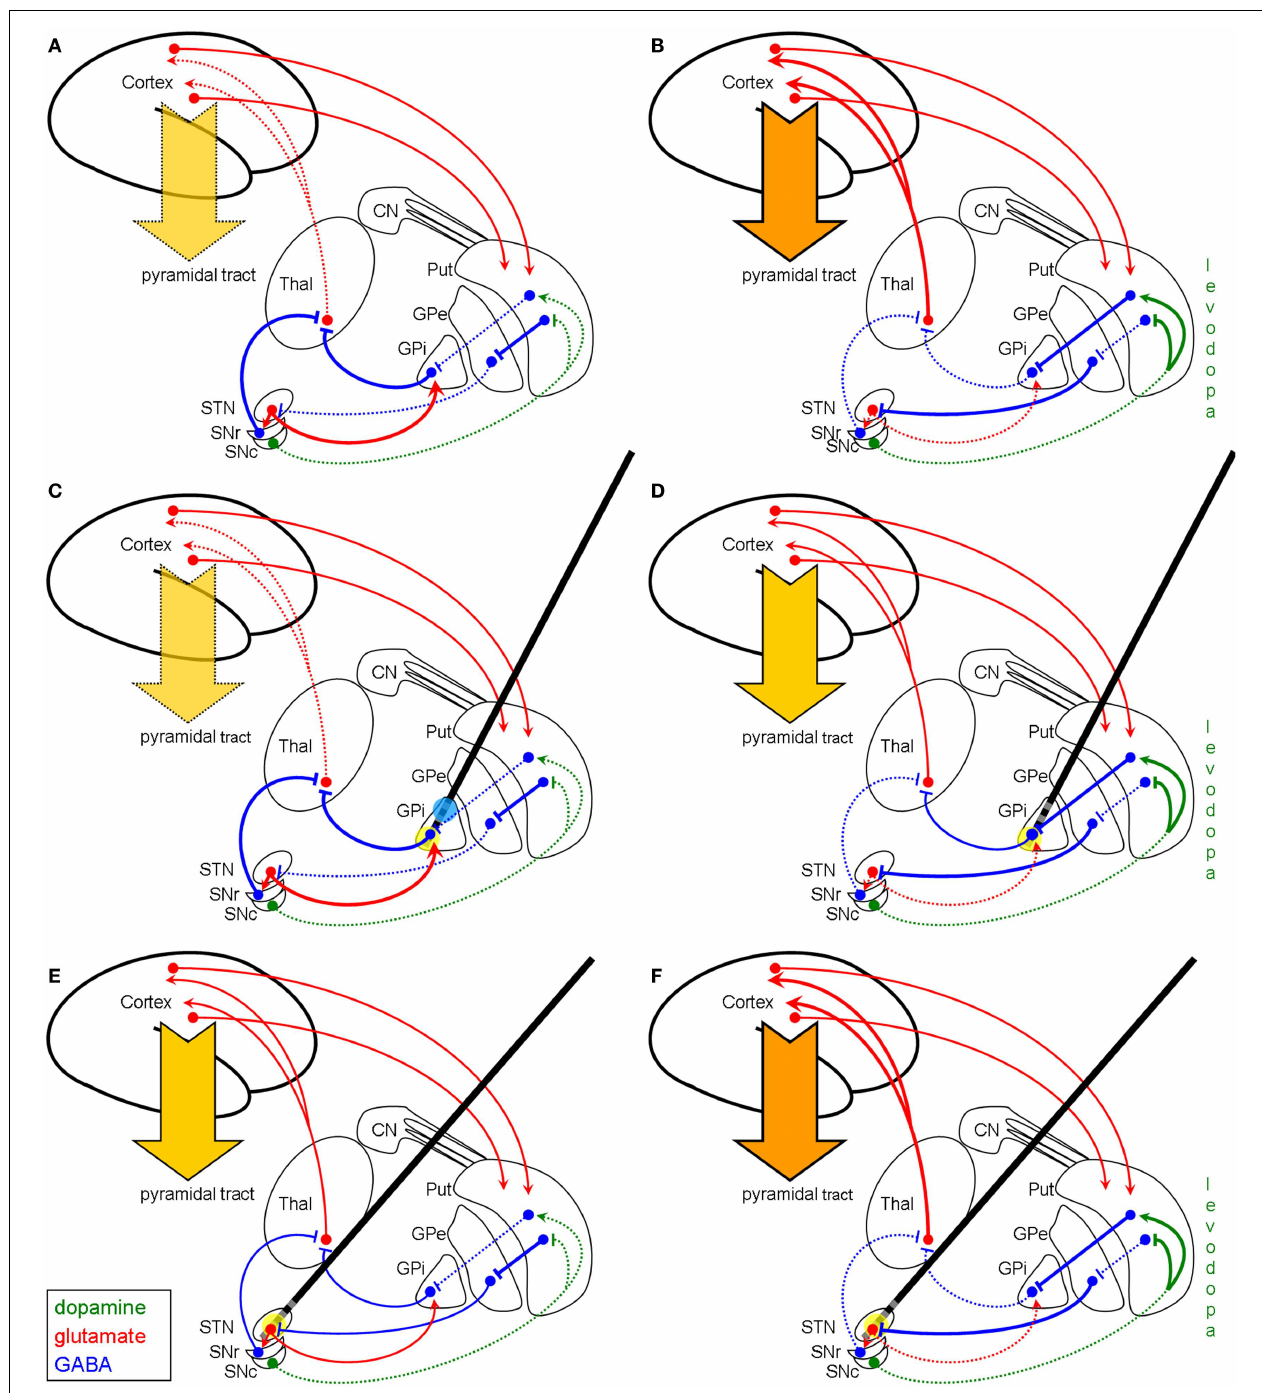
FIGURE 3 | Schematic model of the basal ganglia in IPD with and without modulation by HFS (coronar view) . Left column (A,C,E) : basal ganglia model of hypokinetic IPD. Right column (B,D,F) : basal ganglia model of the hyperkinetic state in IPD after years of levodopa treatment. First row (A,B) : basal ganglia model without DBS modulation. Second row (C,D) : modulation of the network by pallidal HFS (yellow circle).Third row (E,F) : modulation of the basal ganglia network by STN-HFS (yellow circle). The GABAergic hypothesis illustrates why pallidal HFS is not effective in the hypokinetic state of IPD (C) , since the efferent GABAergic axons are maximally recruited, whereas STN-HFS shows good efficacy (E) .